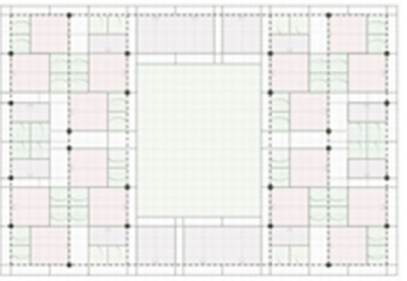
Figure 8. Dashed line: main eaves; dots: drainpipes [12].